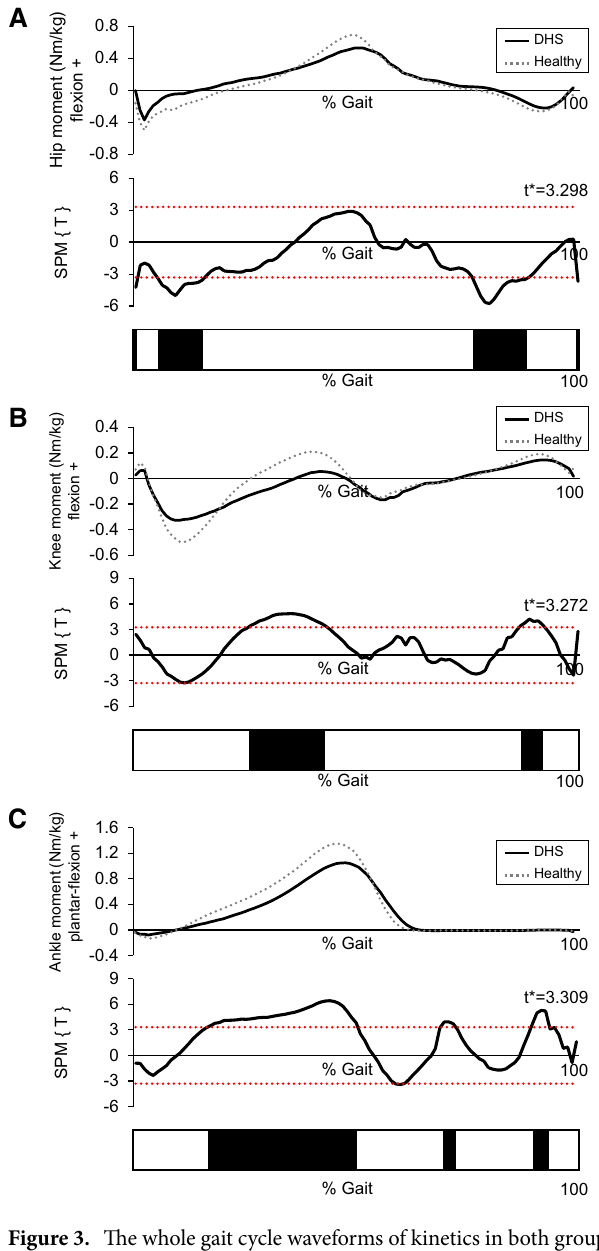
Figure 3. The whole gait cycle waveforms of kinetics in both groups. ( A ) Hip joint angle, ( B ) knee joint angle, and ( C ) ankle joint angle. t* indicate the critical threshold. Lower black bars represent a simplified visualization of the significant areas indicated by the SPM{t} statistic. DHS Dropped head